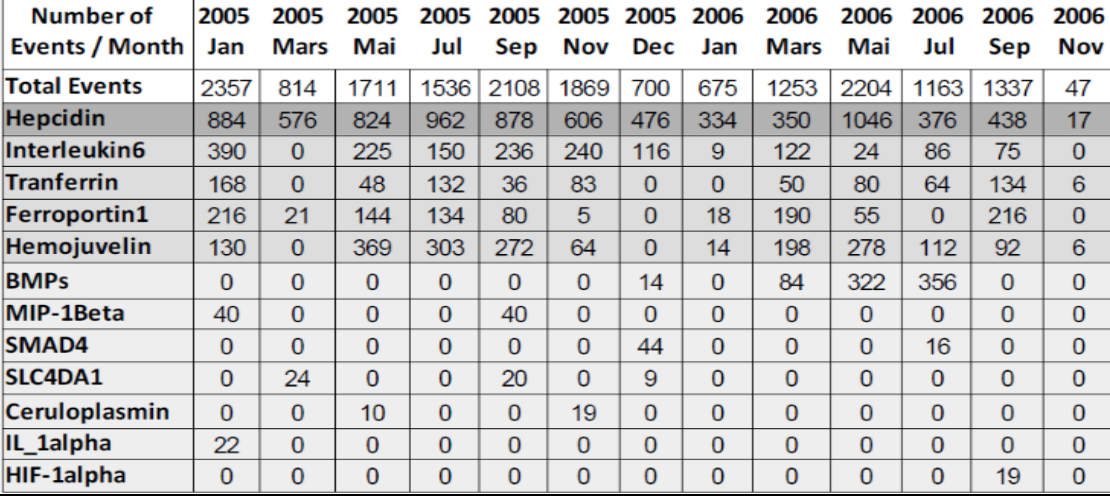
Table 1. Periodic number of events extracted for a sample of